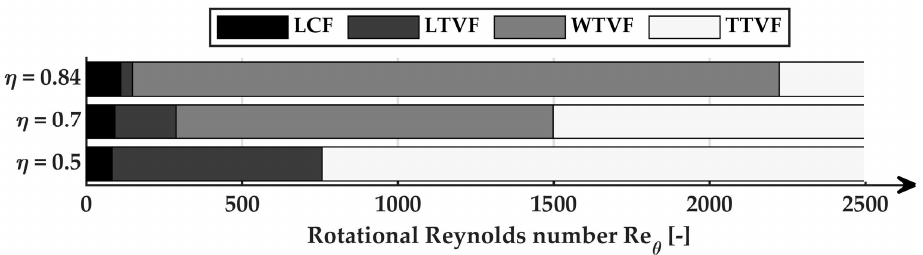
Figure 4. Rotational Reynolds numbers of the flow regime transitions for the different geometries. The axial Reynolds number was set constant at 𝑅𝑒 (cid:3028)(cid:3051) = 15.67, resulting in the volume flow rates 𝑉(cid:4662) = 99.5, 92, and 82 mL ∙ min − 1 for the ratios 𝜂 = 0.84, 0.7, and 0.5, respectively.